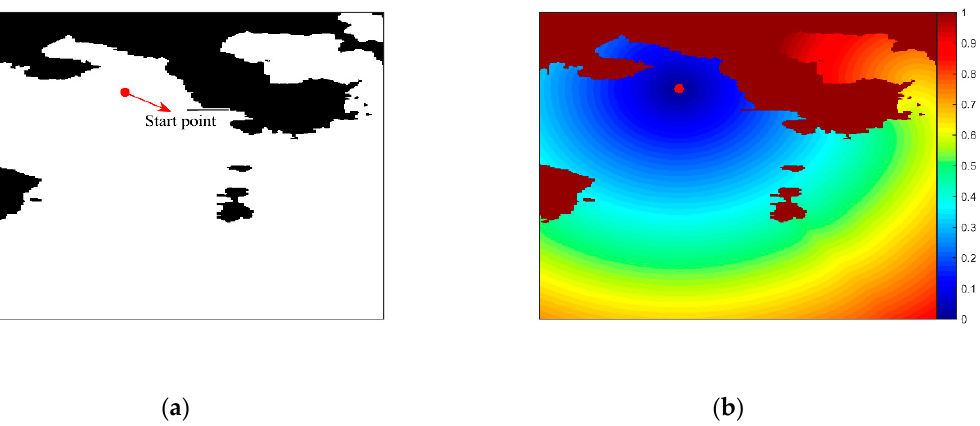
Figure 20. Example of the resulting time-of-arrival field applying the LSM to a practical marine environment: ( a ) the marine environment; ( b ) resulting time-of-arrival field by the LSM.